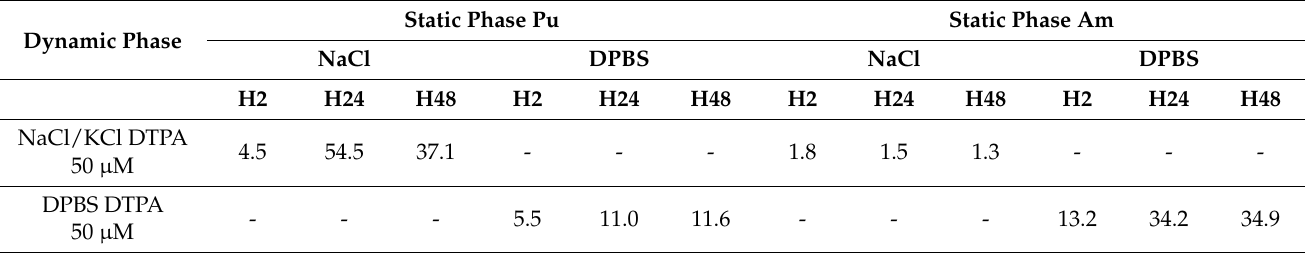
Table 1. Pu/Am transfer enhancement in the presence of DTPA. Ratio of medians of transferred fractions from DTPA treated vs. untreated obtained from 2–4 experiments in triplicate.